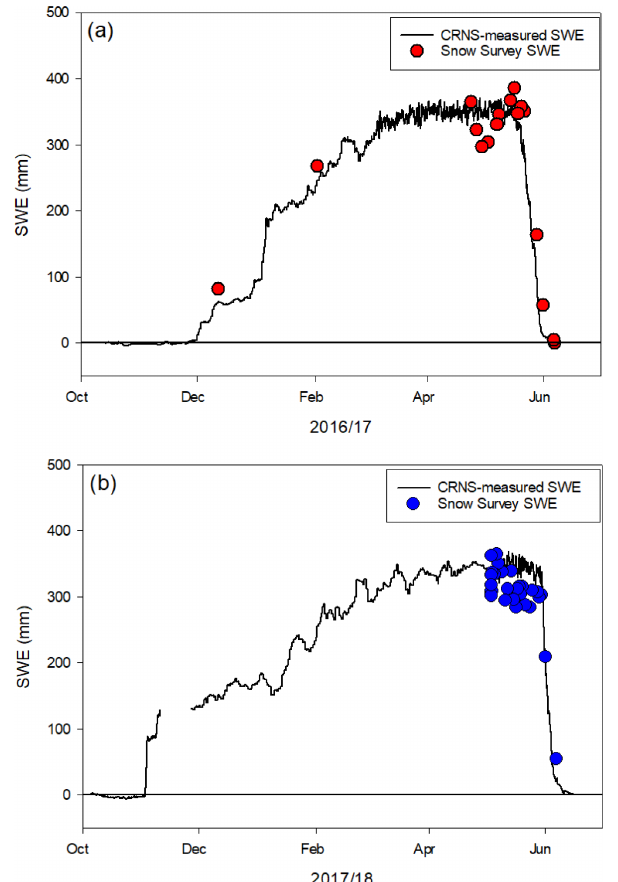
Figure 7. Continuous measurement of a snowdrift at TVC in the (a) 2016/2017 and (b) 2017/2018 winter seasons. CRNS-measured SWE was averaged from the five CRNSs, and values were calcu- lated using Eq. (4).